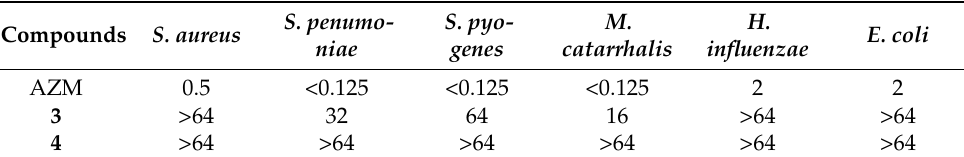
Table 3. Antibacterial activity (expressed as MIC in μ g/mL) against S. aureus , S. pneumoniae , S. pyogenes , M. catarrhalis , H. influenzae , and E. coli . Compounds